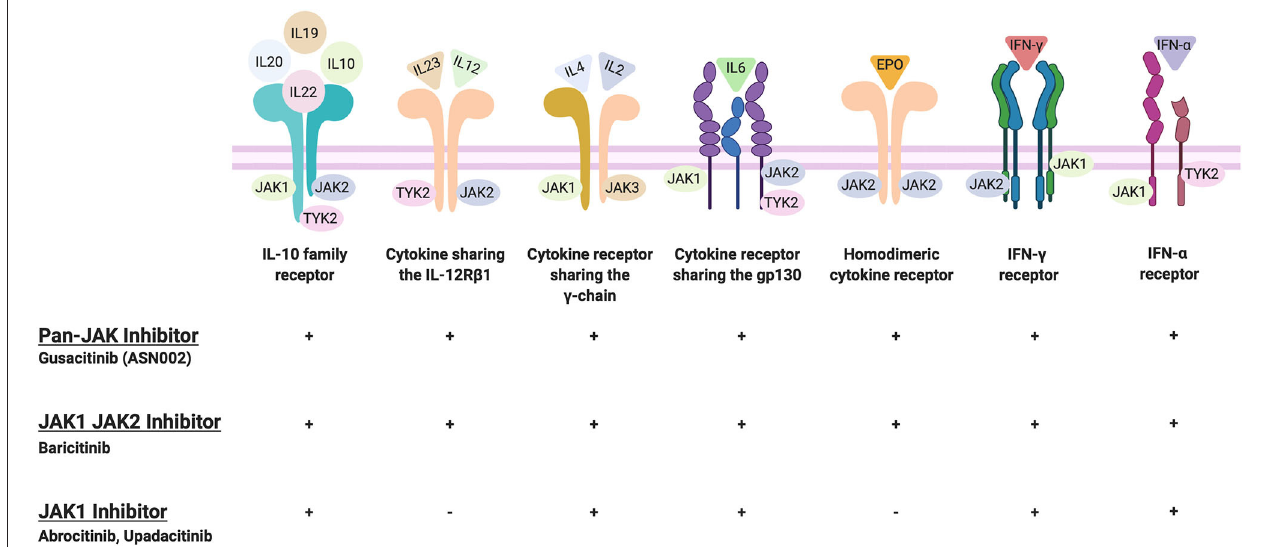
FIGURE 3 | JAKi selectivity toward cytokine receptors. Created and retrieved from